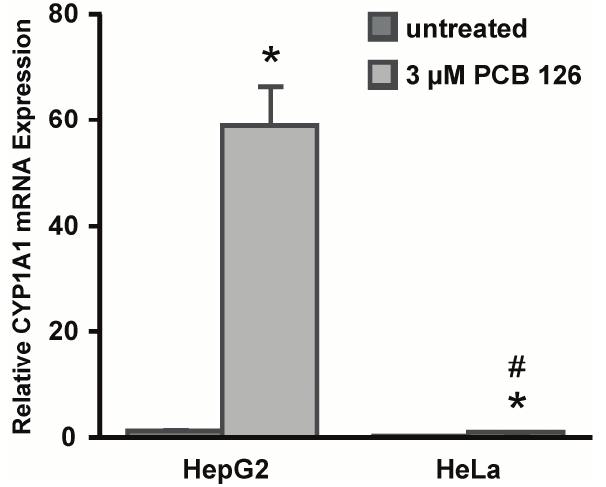
Figure 1. Cytochrome P450 1A1 (CYP1A1) mRNA expression is differentially induced by the aryl hydrocarbon receptor (AhR) agonist 3,3',4,4',5-pentachlorobiphenyl (PCB 126) in HepG2 and HeLa cells. HepG2 and HeLa were treated with 3 µM PCB 126 for 6 h. CYP1A1 mRNA expression was determined by quantitative real-time reverse transcription polymerase chain reaction (qRT-PCR). Analysis was performed with normalization to ribosomal protein, large, P0 (RPLP0) mRNA. RNA expression levels significantly ( p < 0.05) greater than untreated controls are indicated by an asterisk ( * ). RNA expression levels significantly ( p < 0.05) different between PCB 126 treated HepG2 cells and PCB 126 treated HeLa cells are indicated by a number sign (#). Error bars = SEM; n =